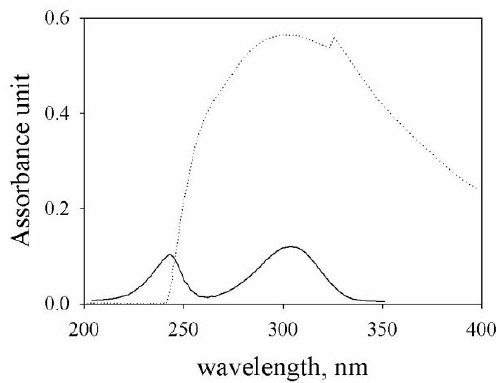
Figure 1. Ultraviolet (UV) absorbance spectrum of organic matter contained in humic acids (HA) soil (20 mg / L) (dotted line) and of eluent (continuous line).